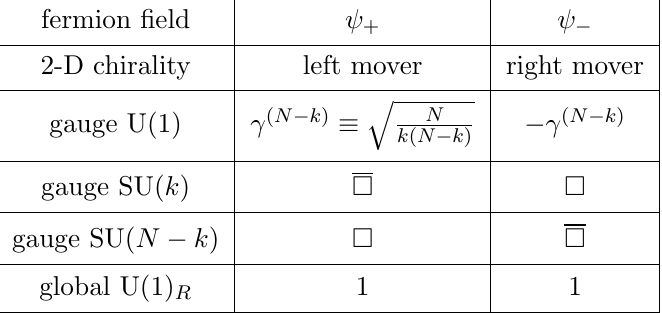
Table 1 . The massless fermions of the k -wall worldvolume theory and their charges under the U(1) (cid:2) SU( N (cid:0) k ) (cid:2) SU( k ) gauge group and the bulk global U(1) R chiral symmetry. Opposite chirality fermions are in conjugate representations, thus the 2-D k -wall theory is axial, while the bulk U(1) R chiral symmetry is vectorlike on the 2-D worldolume. A Z 2 N subgroup of U(1) R